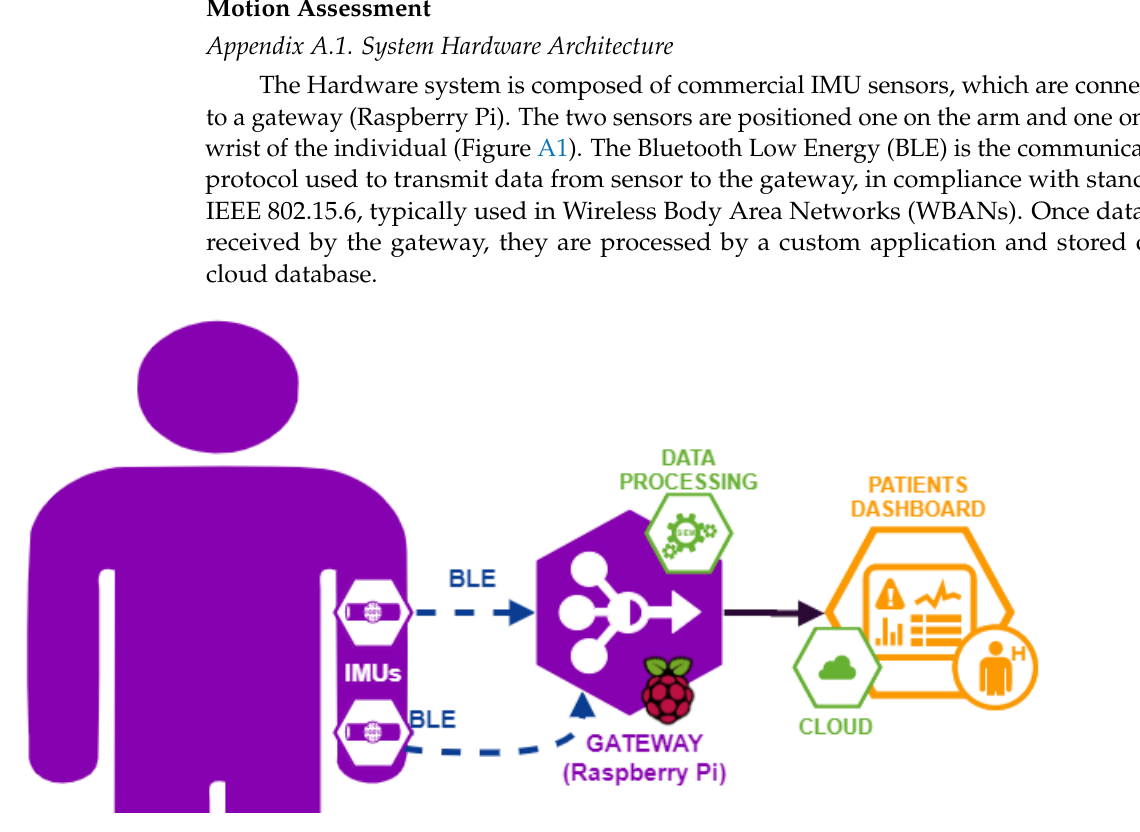
Figure A1. Scheme of the Hardware Module of the system. In purple, the components of system hardware module; in green, the components of system software module and in orange, the components of data aggregation/visualization